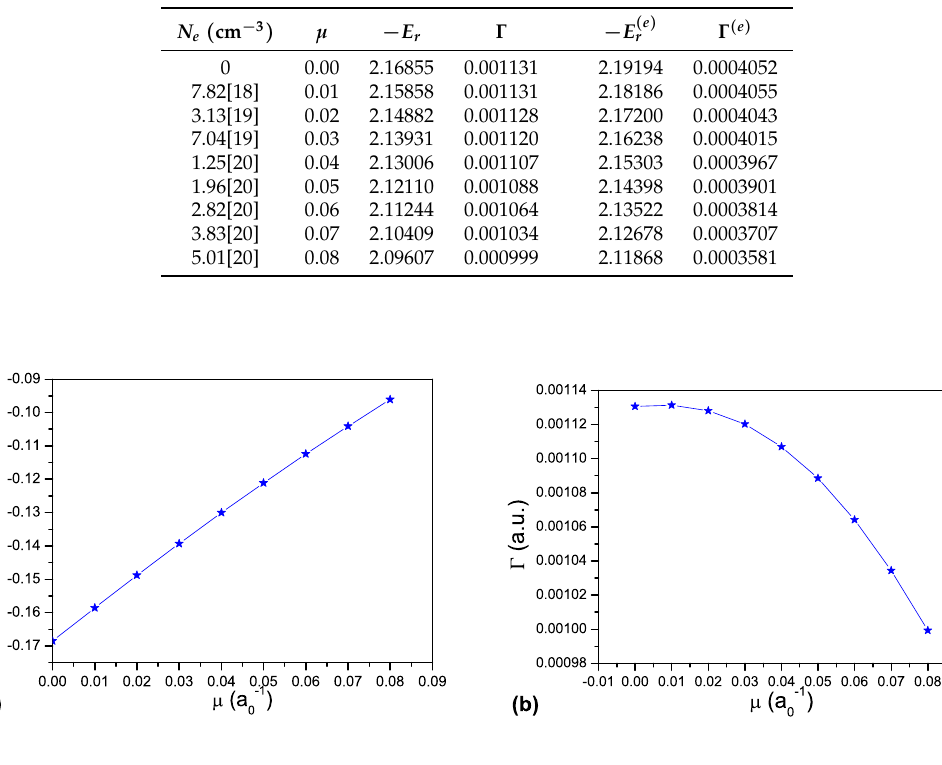
Figure 2. ( a ) Resonance energies E r in e − − He ( 1 s 2 s 2 ) system for different values of the screening parameter µ ; ( b ) Resonance width Γ corresponding to the resonance energies in (a) for different values of the screening parameter µ corresponding to kT = 4.0 eV and N e in the range ( 0,5.01 × 10 20 ) cm − 3